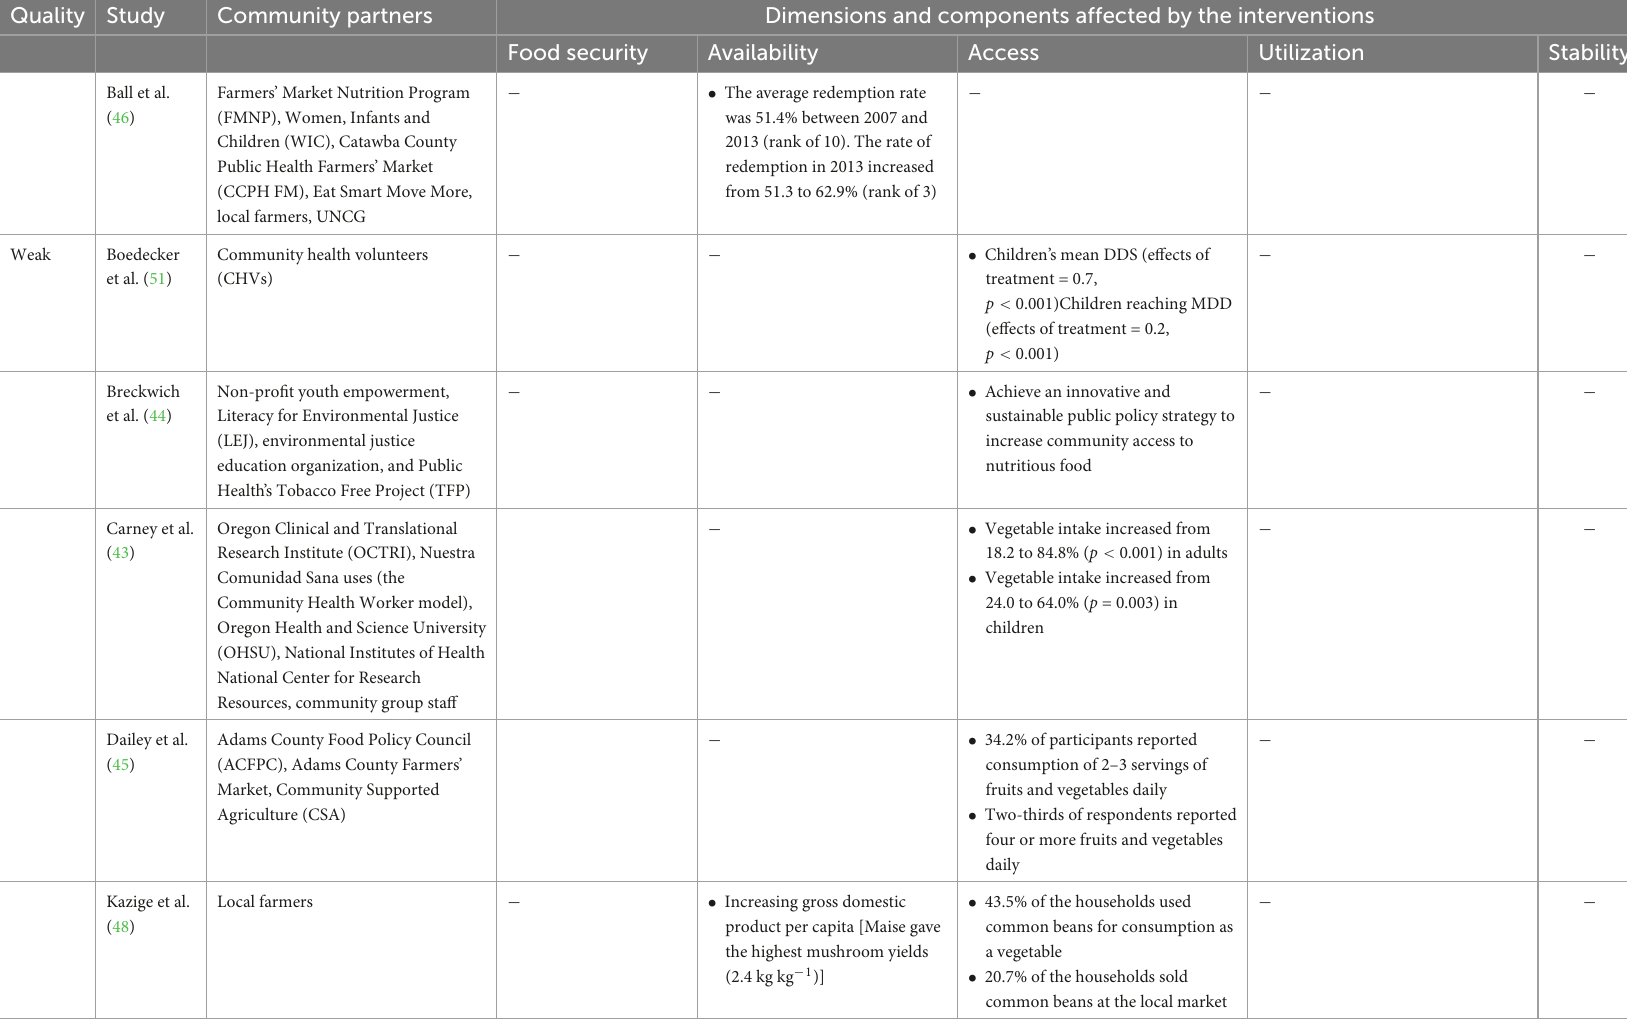
TABLE 4 Summary of community partners of the interventions and their significant effect on the food security dimensions and their components by the quality level of included studies. Quality